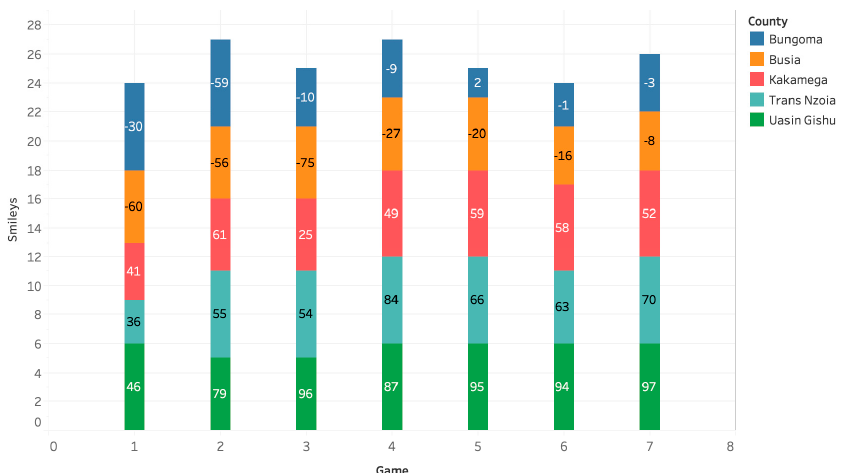
Figure 4. Grand totals of smileys earned in the seven game sessions for the five county governments.